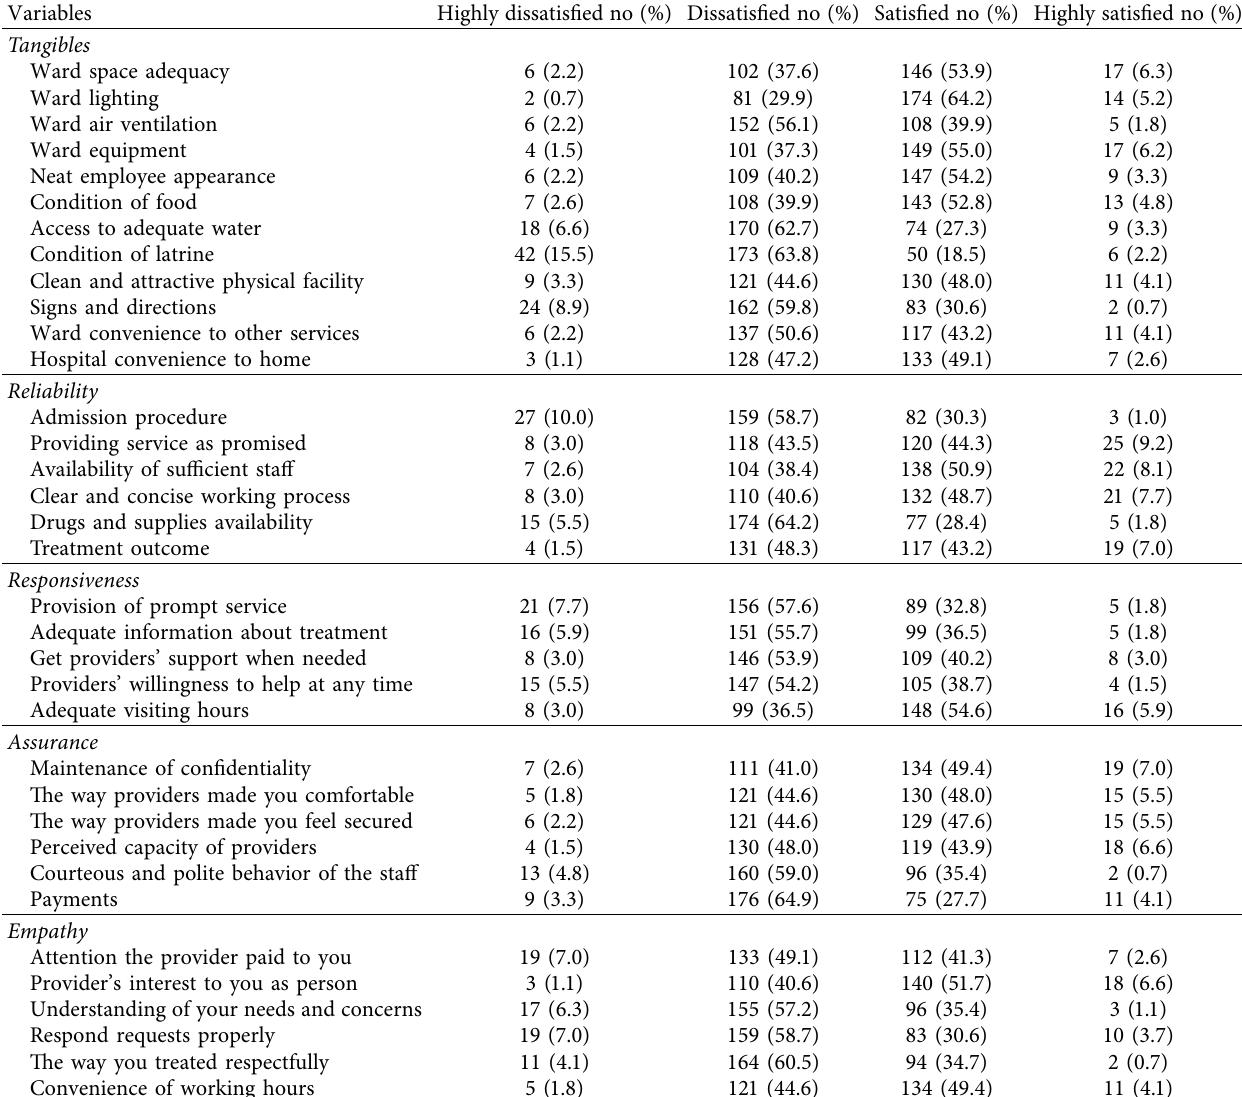
Table 2: Patient satisfaction status with tangibility, reliability, responsiveness, assurance, and empathy, Gambella Hospital, southwest Ethiopia, 2020 ( n �